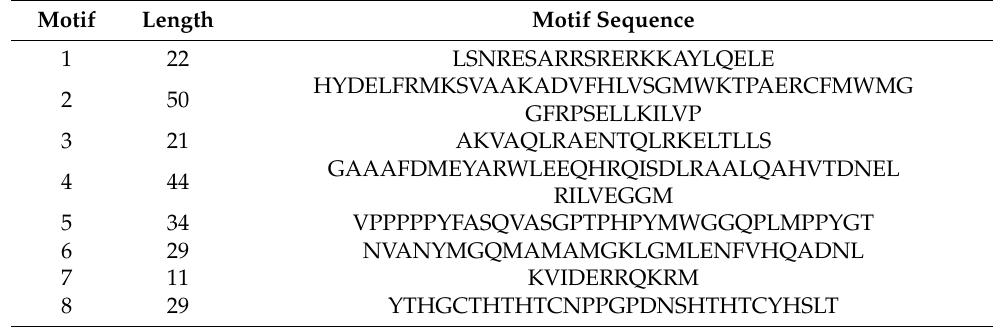
Figure 2. Phylogenetic tree of the bZIP TF family of P. massoniana and A. thaliana . The different color branches and surrounding letters represent different groups. The green stars represent AtbZIPs, and the purple stars represent PmbZIPs. Table 1. Sequences of the motifs of PmbZIP